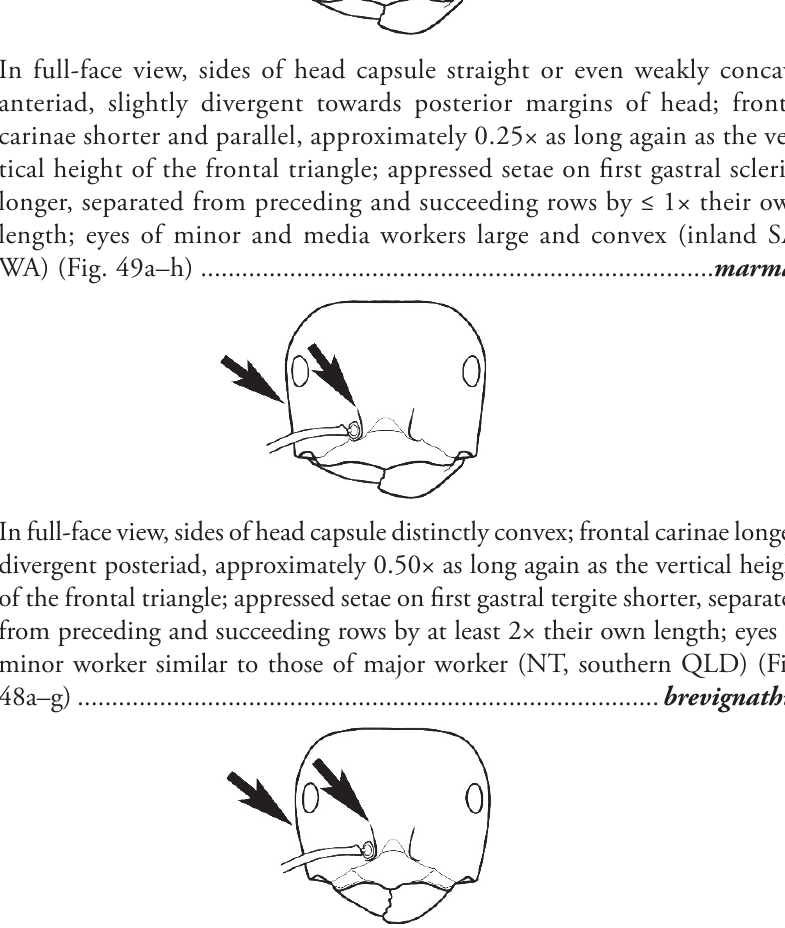
Minor and major worker with five mandibular teeth; major worker with similar mandible to minor worker, not massive, elbowed and directed posteriad; in profile, maxillary palps long, at least in minor worker, attaining mesopleuron when head of ant moderately inclined; in full-face view,